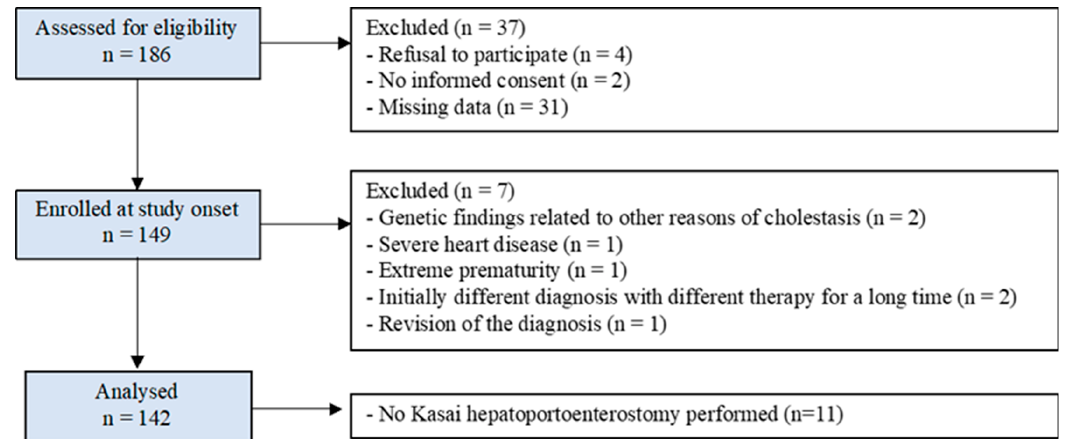
Figure 1. Patient flow diagram.